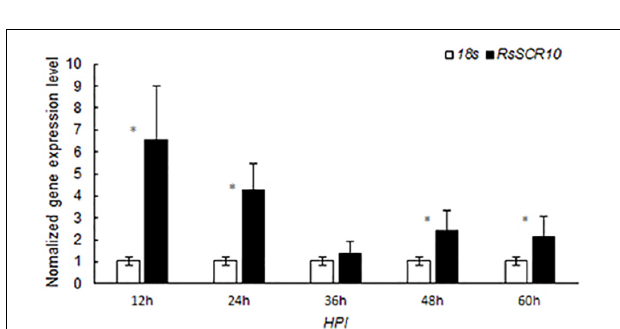
FIGURE 5 | Gene expression patterns of RsSCR10 after inoculation onto rice variety R600, which is relatively susceptible to rice blast. R. solani AG1 IA was used to infect R600, and RsSCR10 expression levels were determined at different time points. Error bars represent standard errors from three biological replicates. *Statistical significance at 5% level (Student’s t